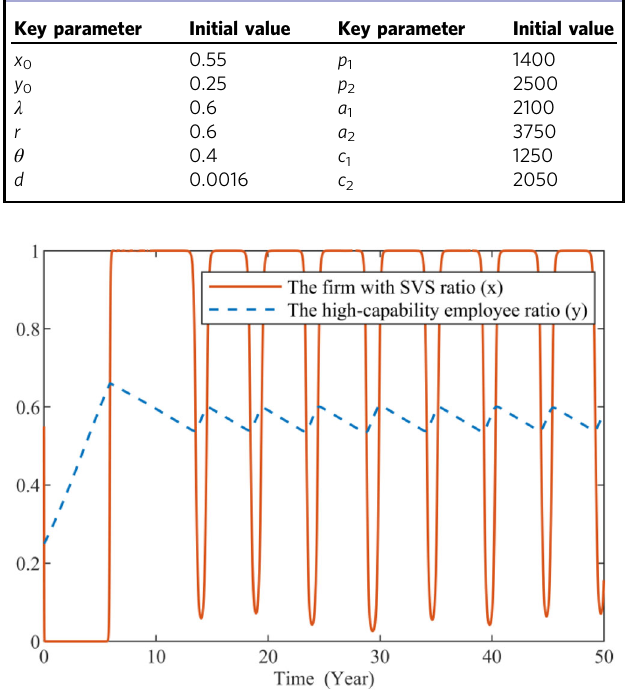
Fig. 4 Evolution of employees under SVS. There is no evolutionarily stable strategy with the mechanism of static value sharing based on initial